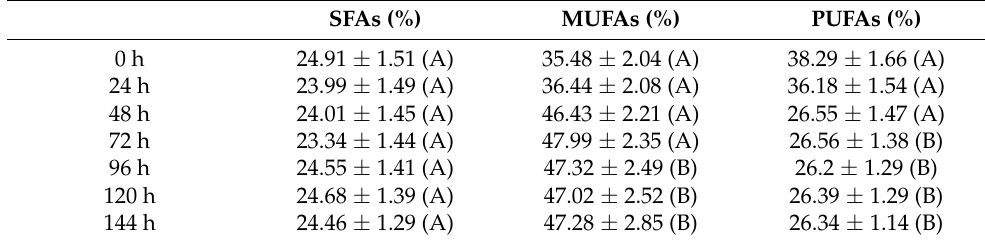
Table 2. Fatty acids contents at different fermentation